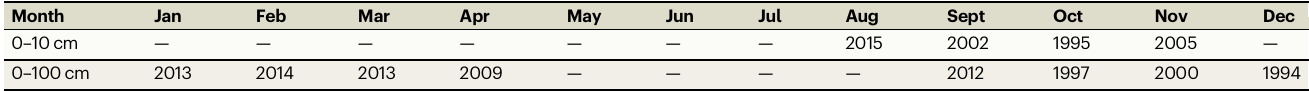
Em dashes ( — ) indicate nosigni fi cantsignals.